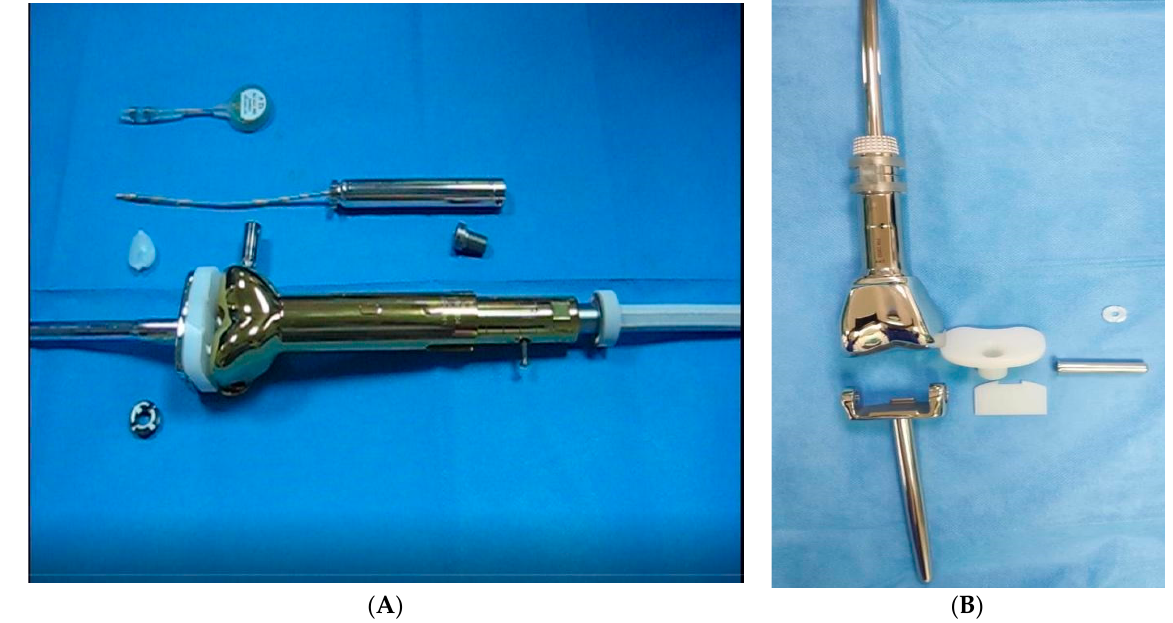
Figure 1. ( A ): The MUTARS ® Xpand Growing Prostheses (on the right). ( B ): The Juvenile Tumor System (JTS) (on the left).